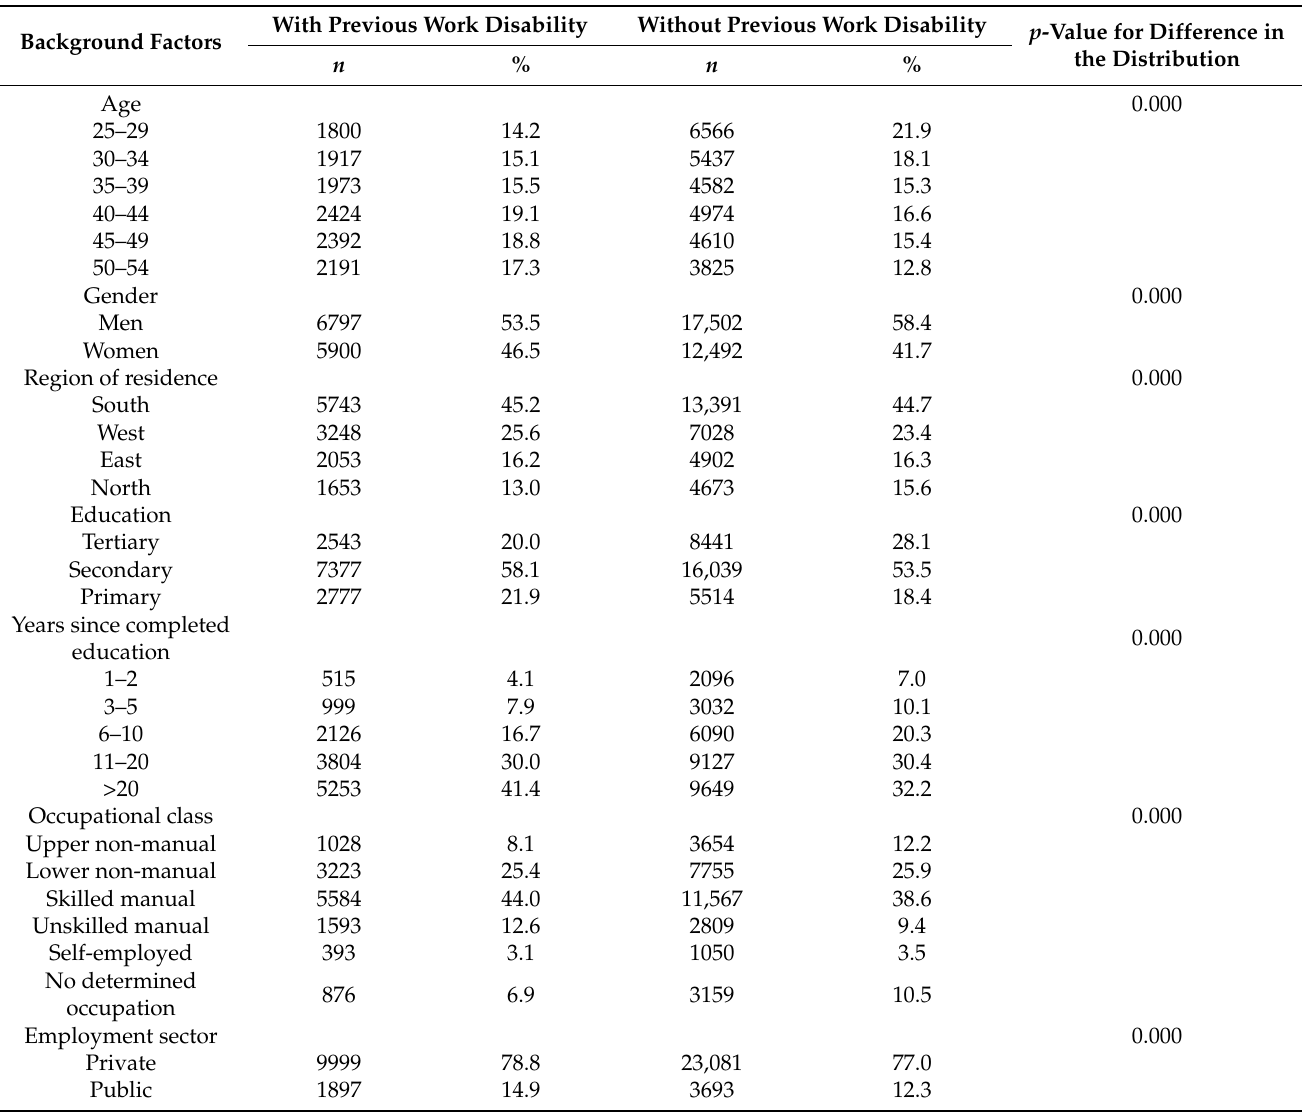
Table 1. Distribution of background factors amongst the study population of vocational labour market trainees with and without previous work